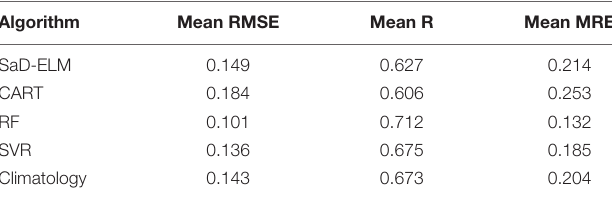
TABLE 7 | Predictions of SIC from January 1st to June 30th, 2000 (lead time = 1